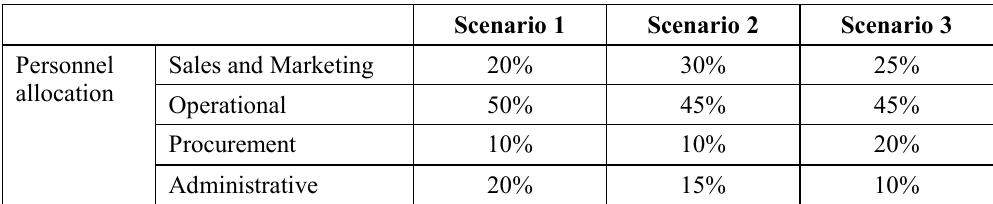
Table 2. Scenarios for model